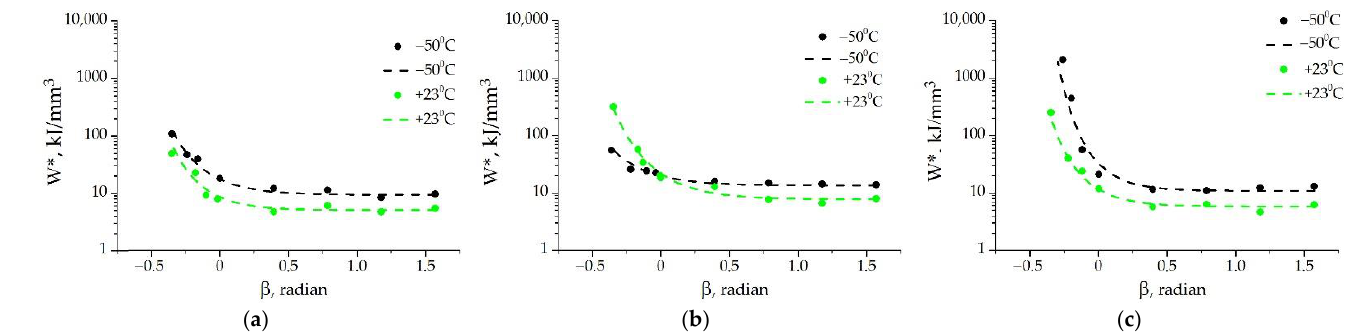
Figure 7. The fracture loci W *( β ) of the adhesive joints with A1 ( a ), A2 ( b ), and A3 ( c ): dots — experimental data, dashed lines — approximation by Equation (9).